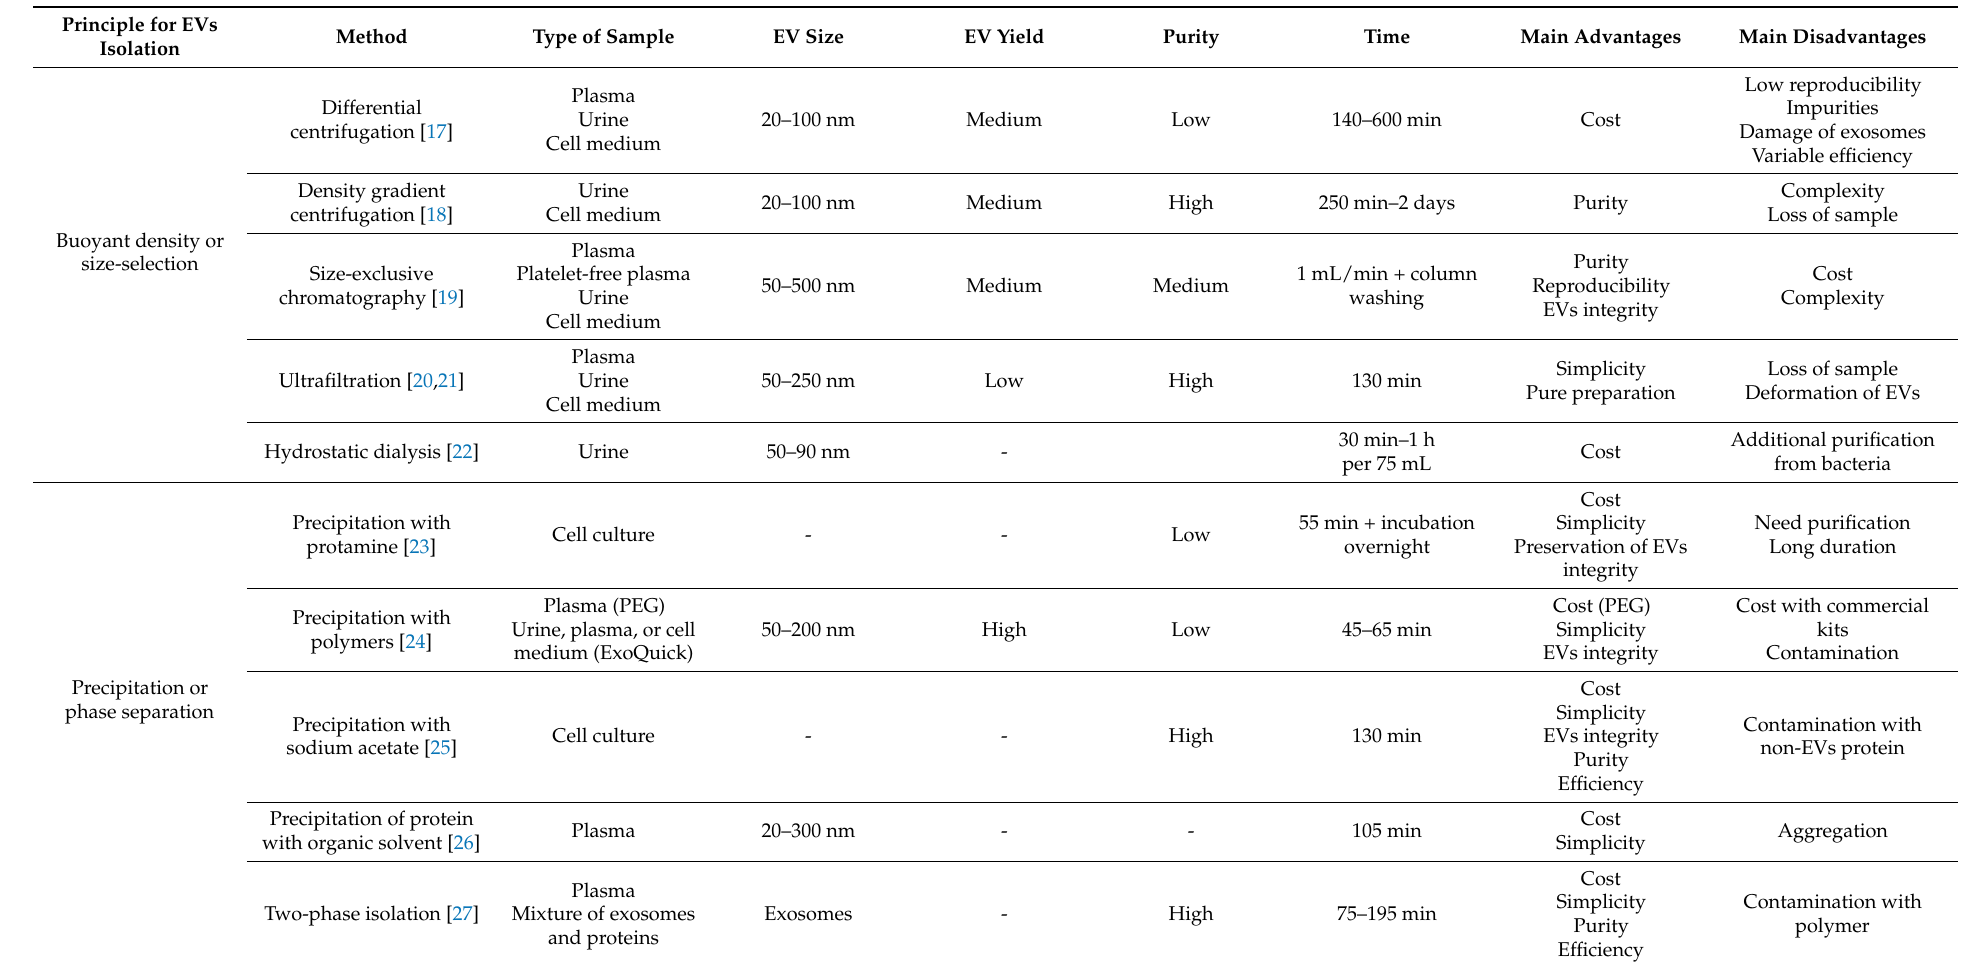
Table 1. Methods of isolation of extracellular vesicles